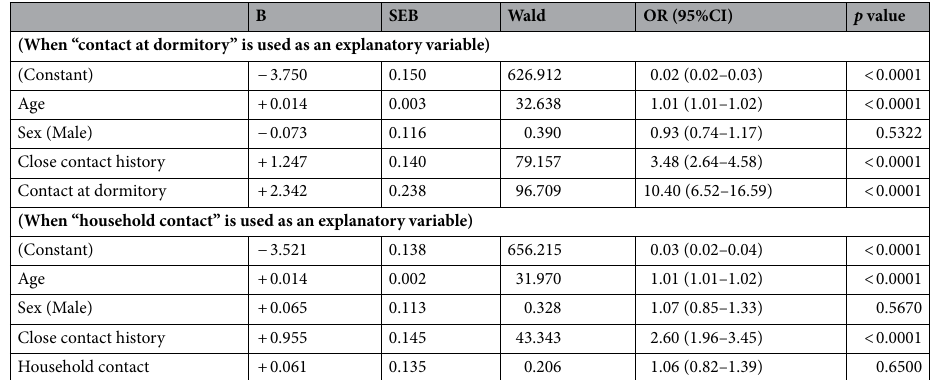
Table 2. Binary logistic regression analysis for potential predictors of SARS-CoV-2 test-positive results. Logistic regression analyses were performed for 4550 individuals with identified places of contact with COVID-19 patients. The upper half shows the results when contact in a dormitory, irrespective of the closeness of contact, is used as an explanatory variable. The lower half shows the results when household contact is used instead. The OR values are equivalent to exp(B). Wald χ 2 statistics (Wald) were calculated using the formula ( B / SEB ) 2 , which is a marker of the significance of each coefficient in the predictive model. B, unstandardized regression coefficient; CI, confidence interval; SEB, standard error of the coefficient; OR, odds ratio.